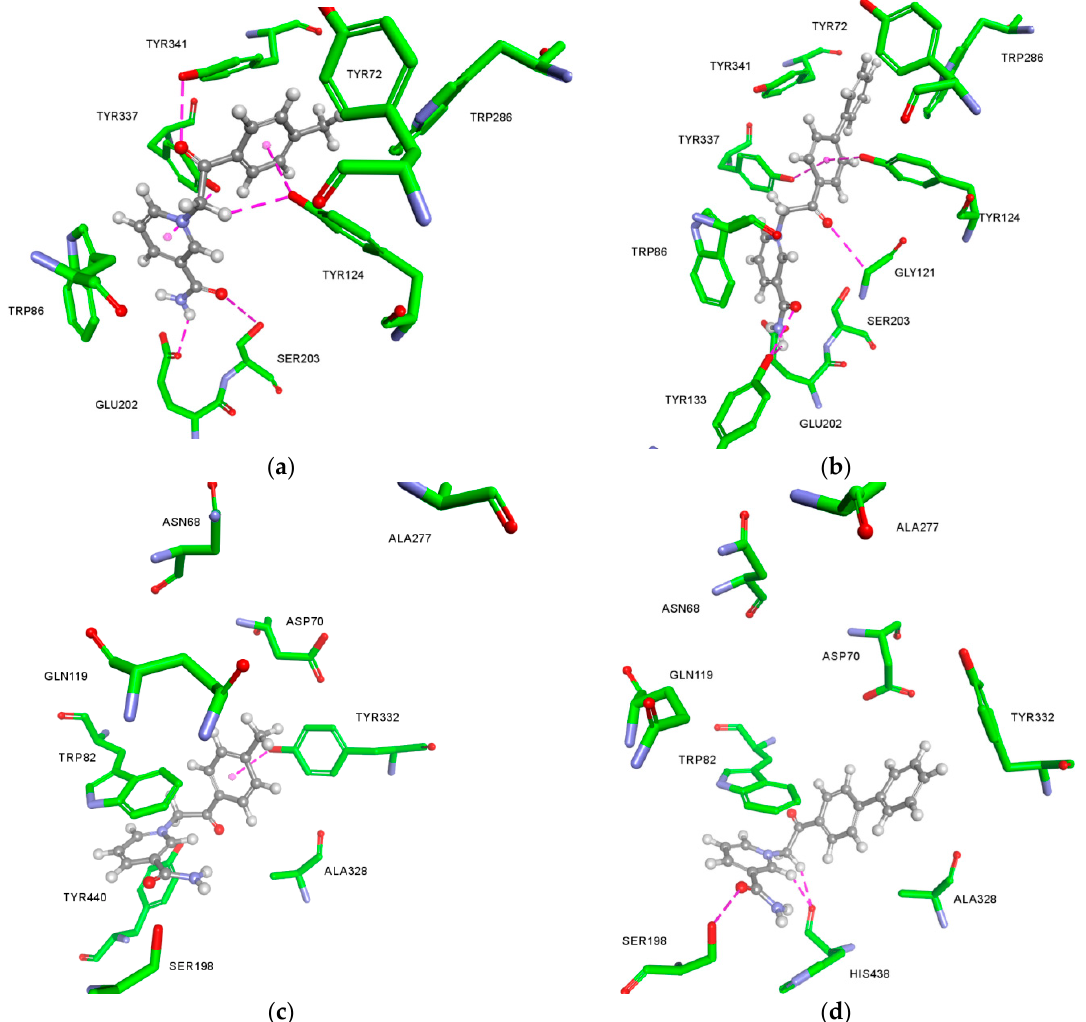
Figure 3. Close-up of AChE and BChE active site from model complexes with compounds 6 ( a , c ) and 8 ( b , d ). Hydrogen bonds are shown in dashed magenta lines.